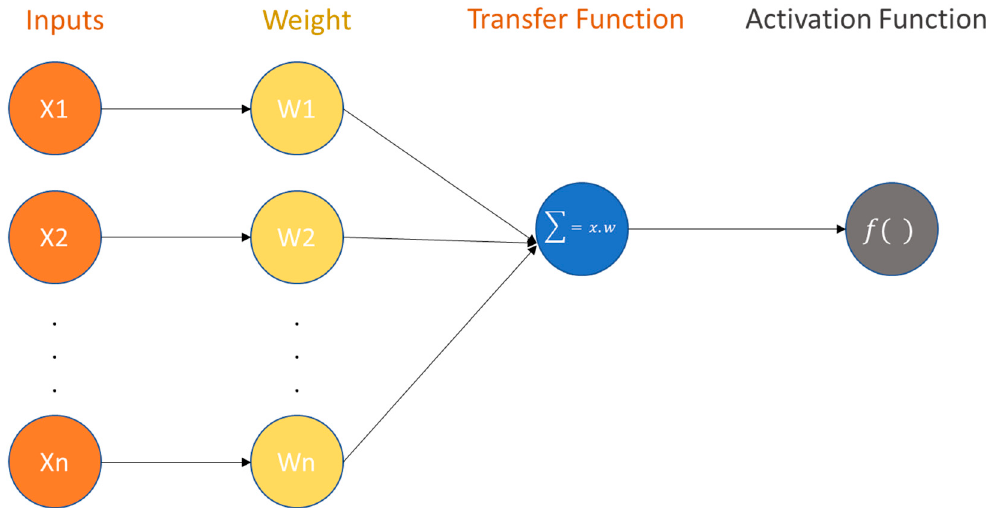
Figure 5. The structure of a neural network’s smallest component, the “perceptron” [47]. Scaler multiplication involves multiplying each input feature by a weight value, which represents the importance of that feature in determining the output. The weighted input values are then summed to produce the final output of the